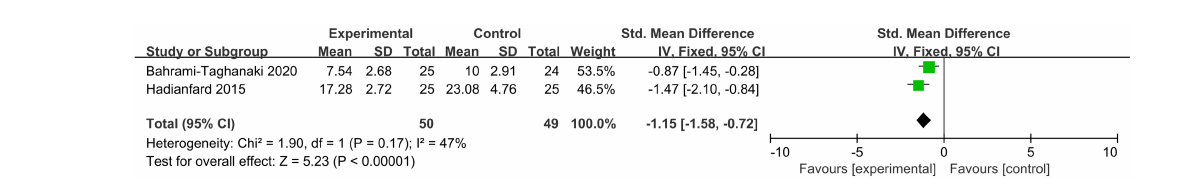
FIGURE3 The frequency of acupoints selection.